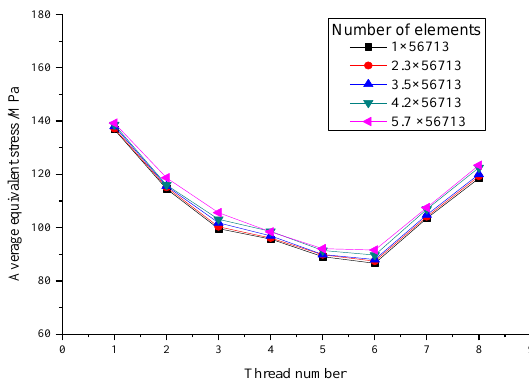
Figure 4. Mesh independence analysis results.